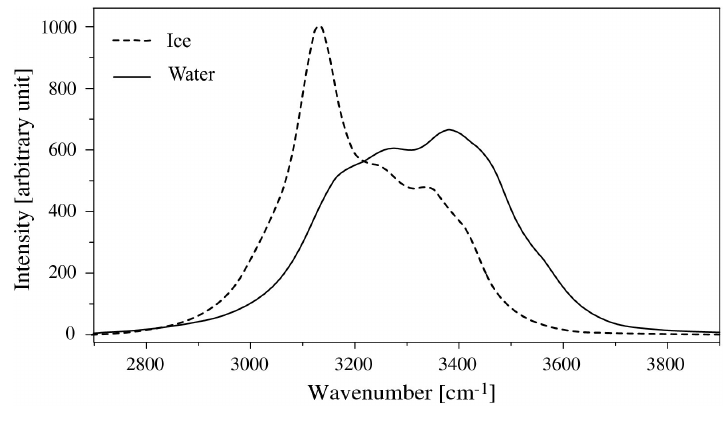
Figure 1. Typical Raman spectra of water at liquid and solid states.